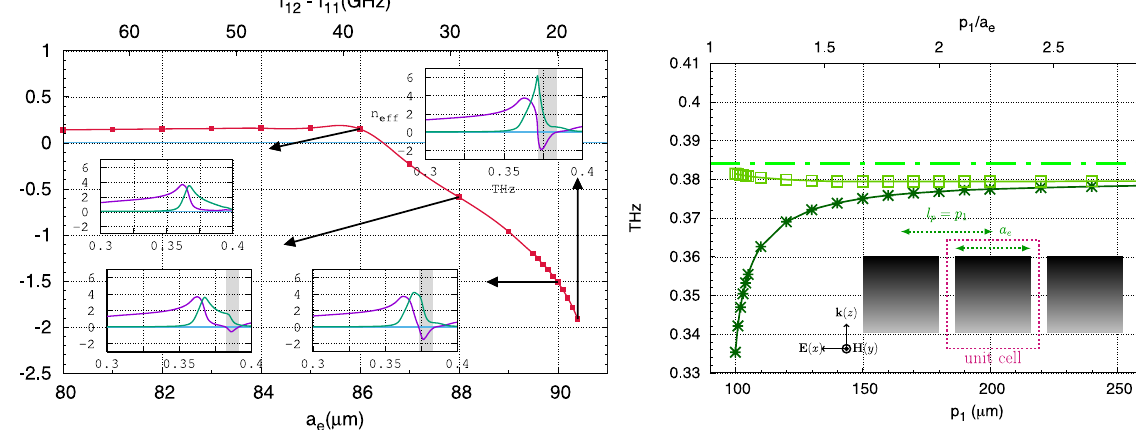
Fig. 5. Electric mode coupling: frequency ( f er ) of the second mode of Mie resonances and of the maximum of absorption ( A er ) as a function of the distance p 1 between two resonators. The unit cell only comprises the electric block. The side length of the resonator is a e = 90 m m. The dashed line denotes the resonance frequency ( f 12 ) of the mode of resonances of the individual